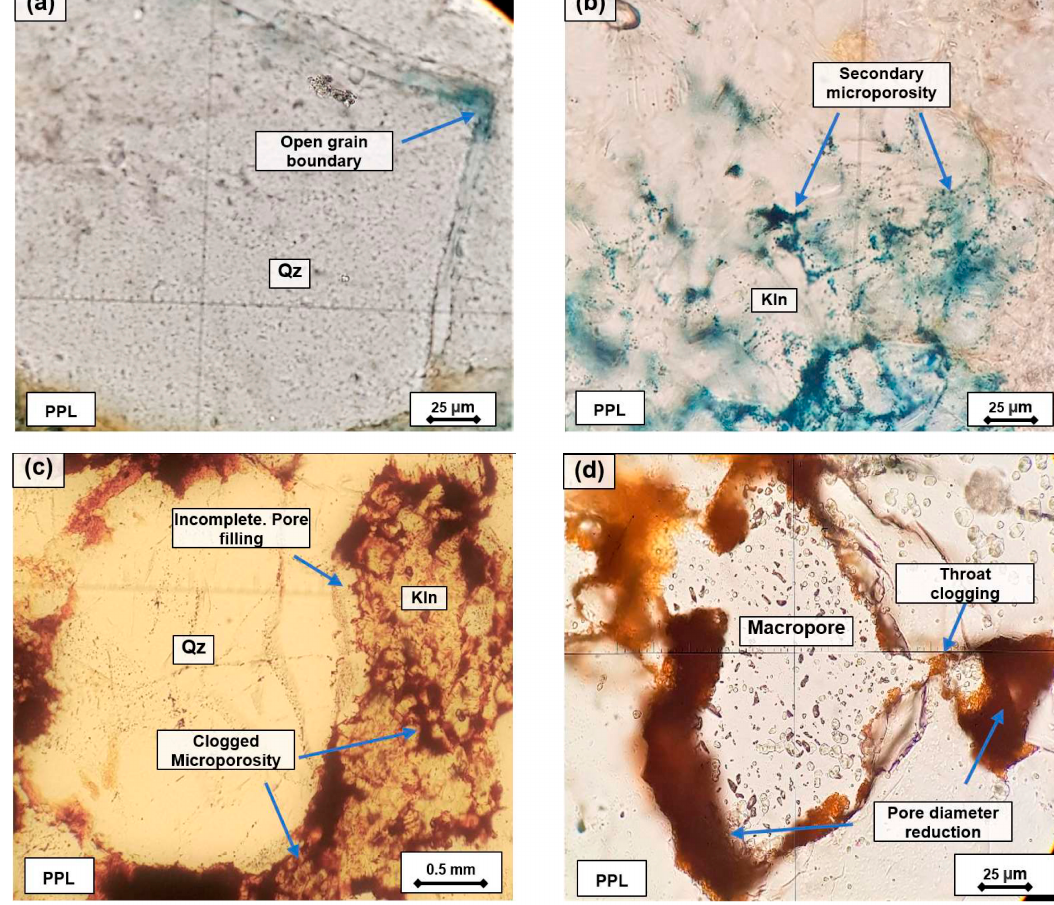
Figure 8. Overview of the rock porosity. ( a ) Open straight-line contact between two quartz grains developing primary porosity. ( b ) Secondary microporosity highlighted by the speckled, pale blue color of the resin. ( c ) Thin section of a weathered interval displaying clogging of primary and secondary microporosity. ( d ) Iron (oxide ‐ ) hydroxides pore ‐ lining, reducing and blocking the connection between pore spaces. Qz = quartz, Kln = kaolinite ‐ group minerals, PPL = plane polarized light.